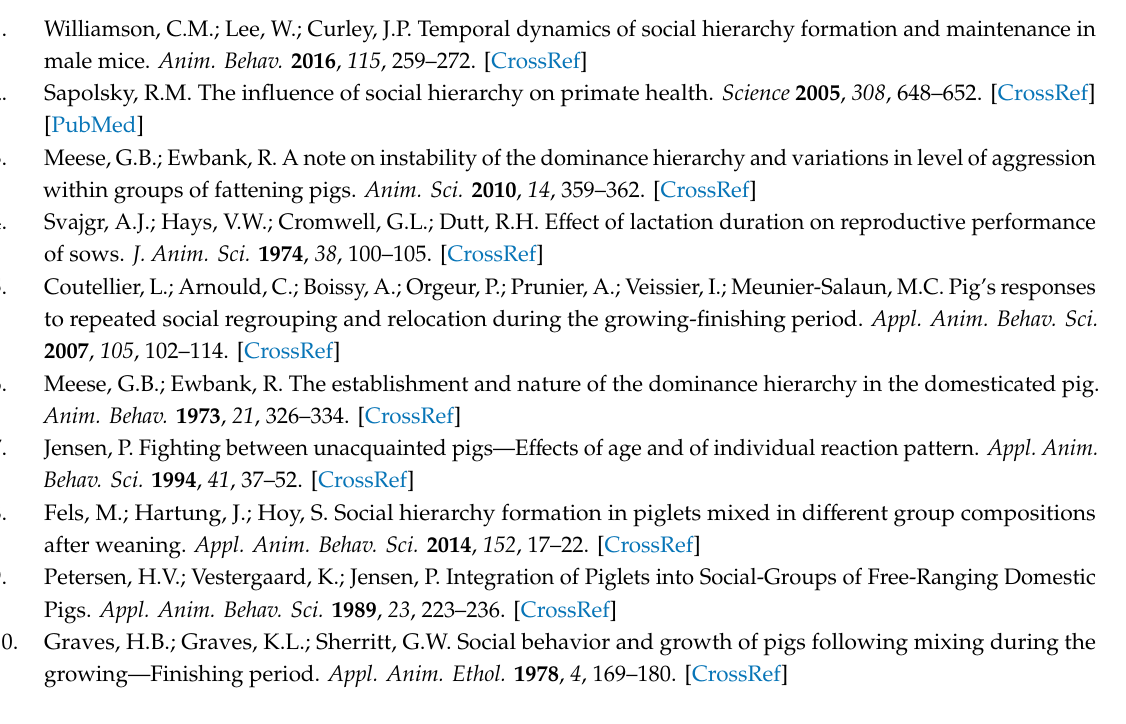
Figure S1: Frequency Win-Loss Sociomatrices. Figure S2: Binarized Win-Loss